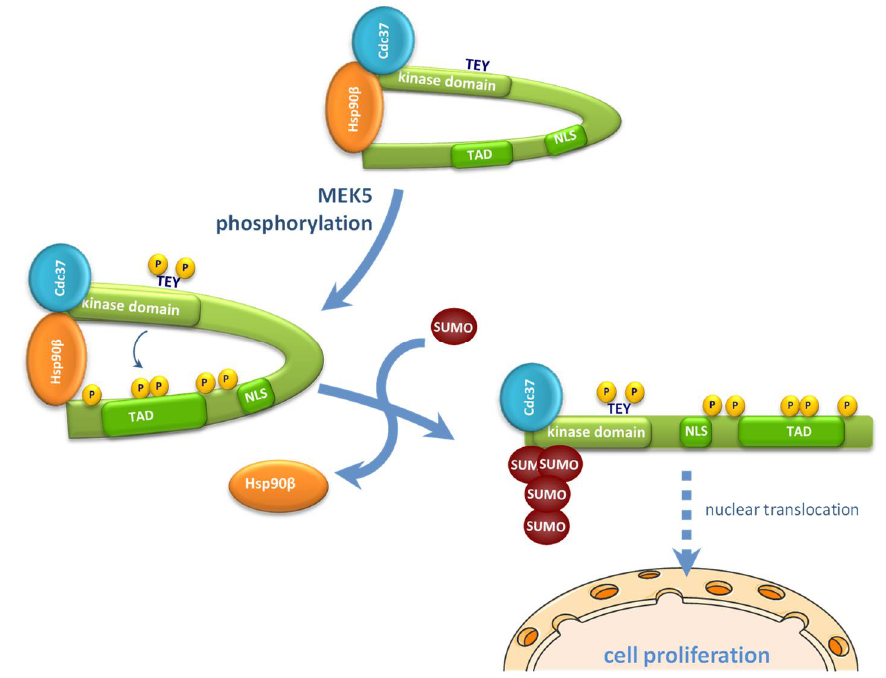
Figure 7. A model for the role of SUMO modification in the mechanism of nucleocytoplasmic shuttling of ERK5. NLS, nuclear localization signal; TAD, transactivation domain; TEY, Thr218/Tyr220.